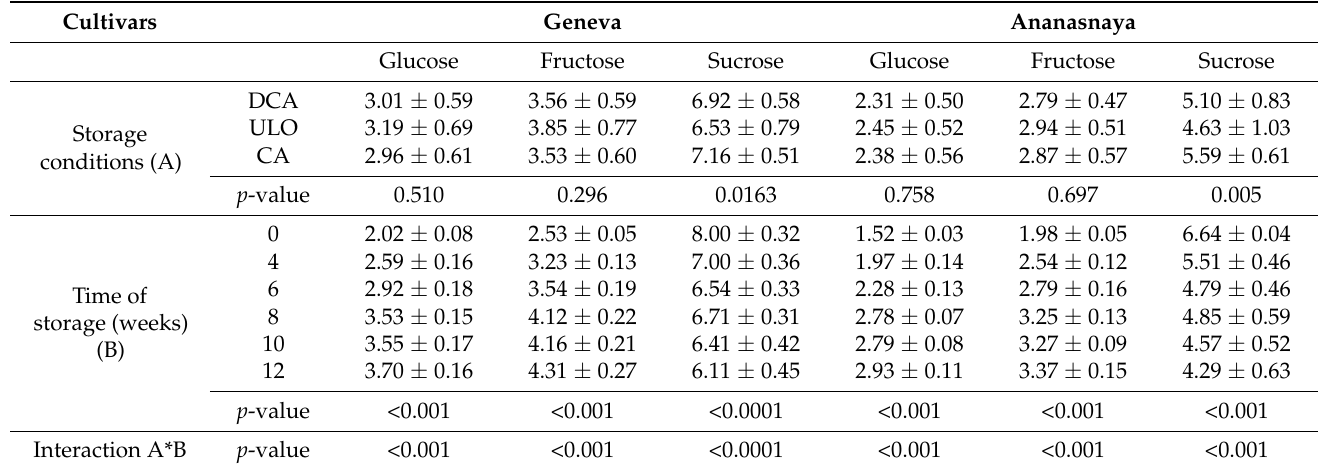
Table 5. Changes in monosaccharide and sucrose contents (g · 100 g − 1 F.W.) measured in ‘Geneva’ and ‘Ananasnaya’ minikiwi fruit in the postharvest period in